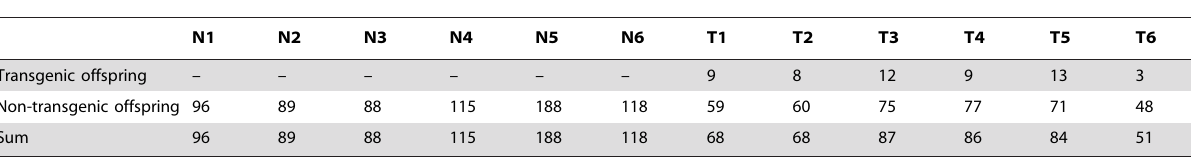
Table 4. Number of offspring form male parents.